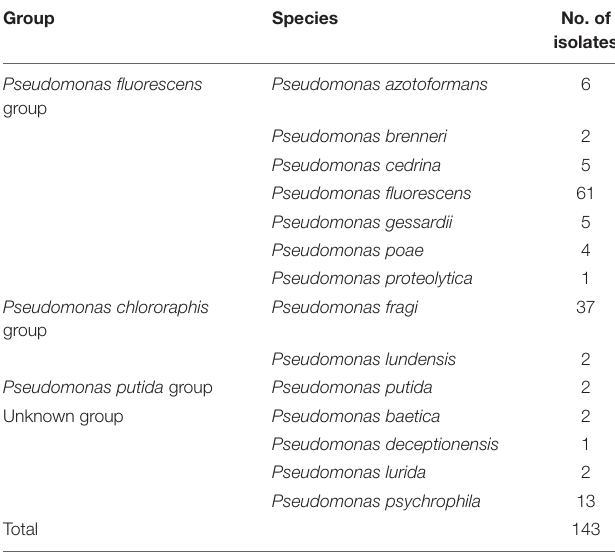
TABLE 1 | Identification of Pseudomonas spp. in raw milk sampled from 87 farms.